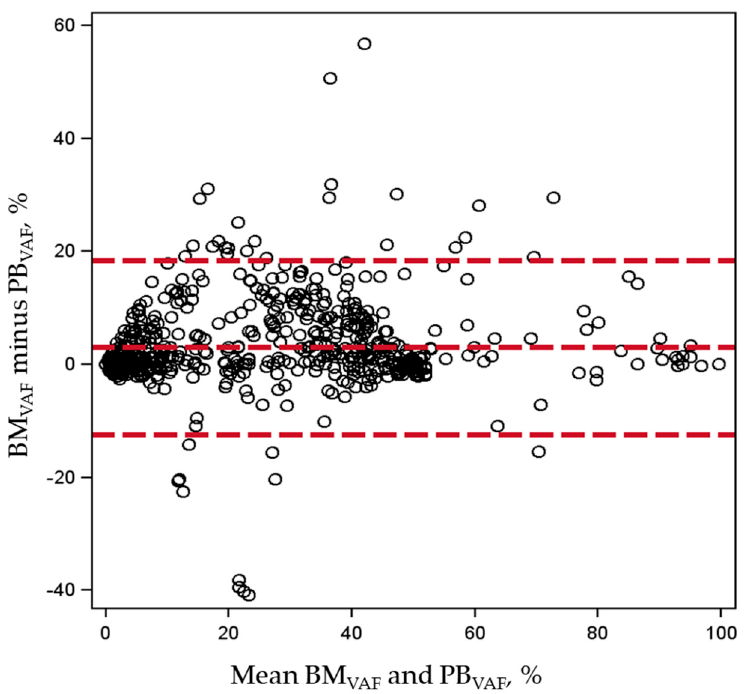
Figure 6. Scatterplot of the variant allele frequency (VAF): difference against the mean. 1 The X − axis shows the mean of the BM VAF and the PB VAF . The Y − axis displays the difference between the BM VAF and the PB VAF . The central red dashed line represents the mean of the difference, (d = 2.92), and the outer red dashed lines correspond to d ± 2 σ , where σ represents the standard deviation of the difference ( σ = 7.71). As discussed in [55], the region between these two outer lines is referred to as the “limits of agreement” and it visualizes the difference between the two methods of